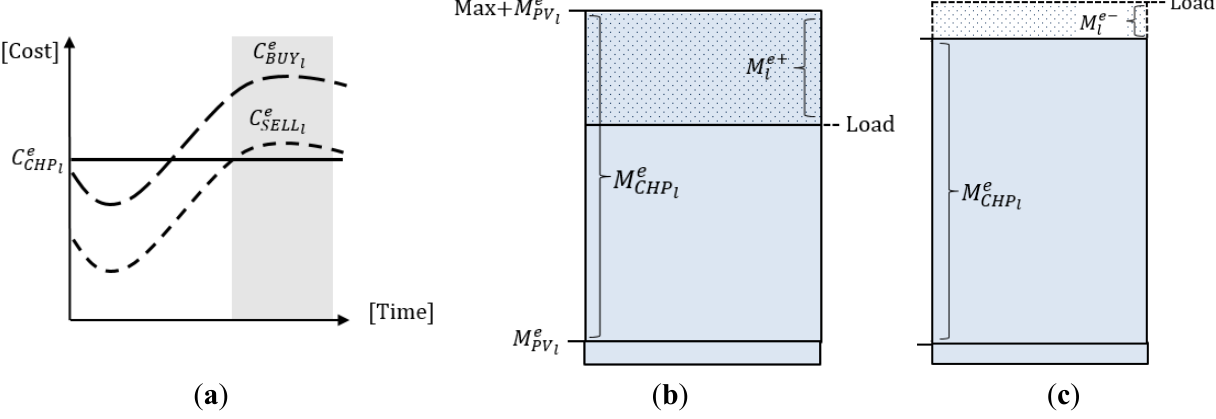
Figure 5. Cases of (cid:1829)